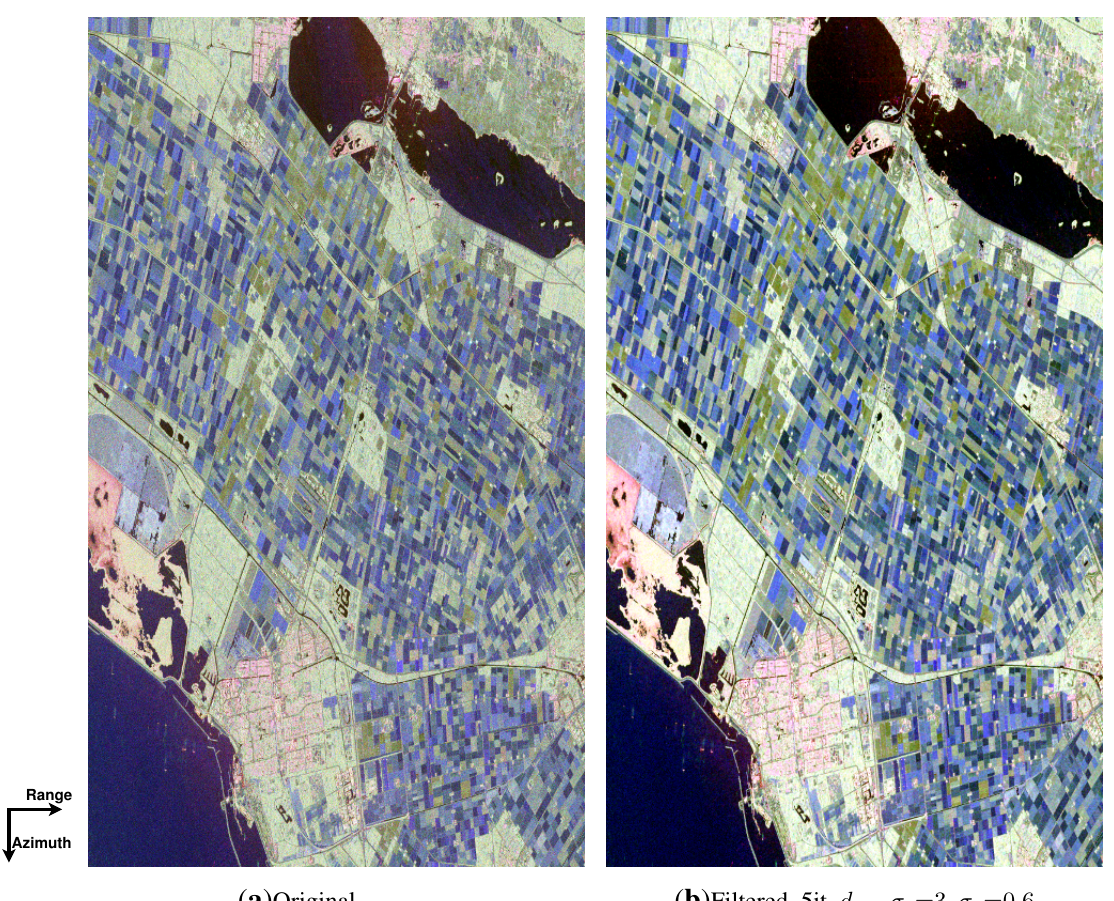
Figure 2. Original ( a ) and filtered ( b ) Pauli RGB images ( | HH − V V | , | HV + V H | , | HH + V V | are assigned to RGB channels, respectively) in slant range radar